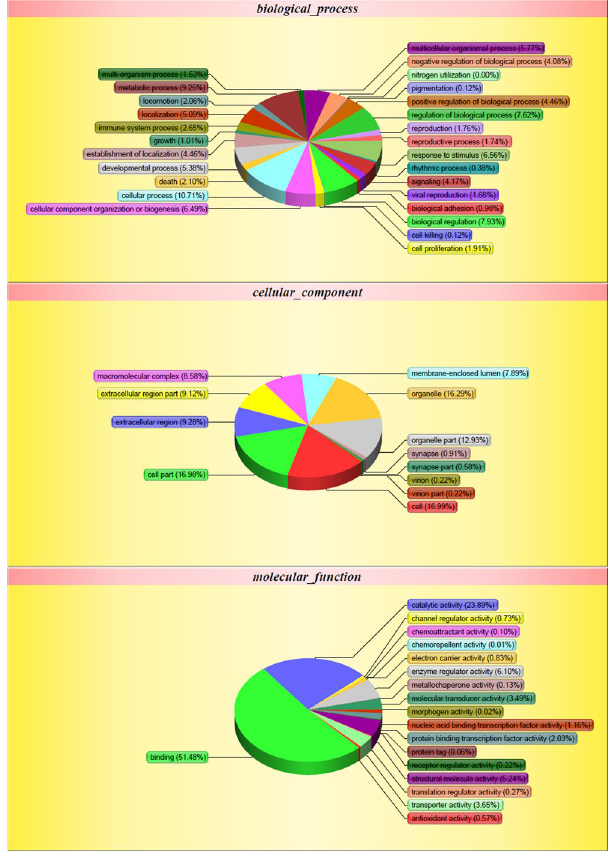
Figure 2. Gene Ontology term of identified protein in iDFC secretome.